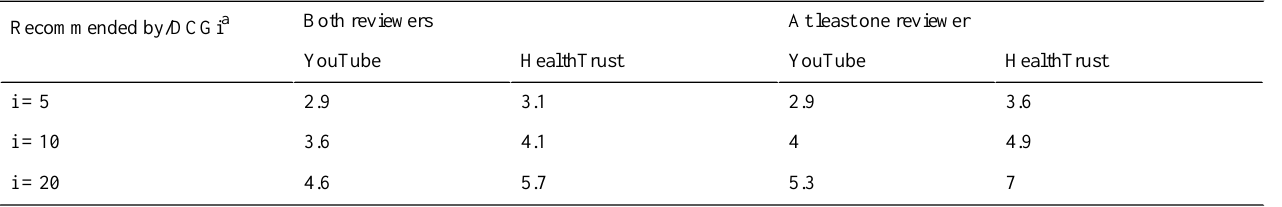
Table 2. Evaluation of the top 20 diabetes channels by discounted cumulative gain (DCG) metric